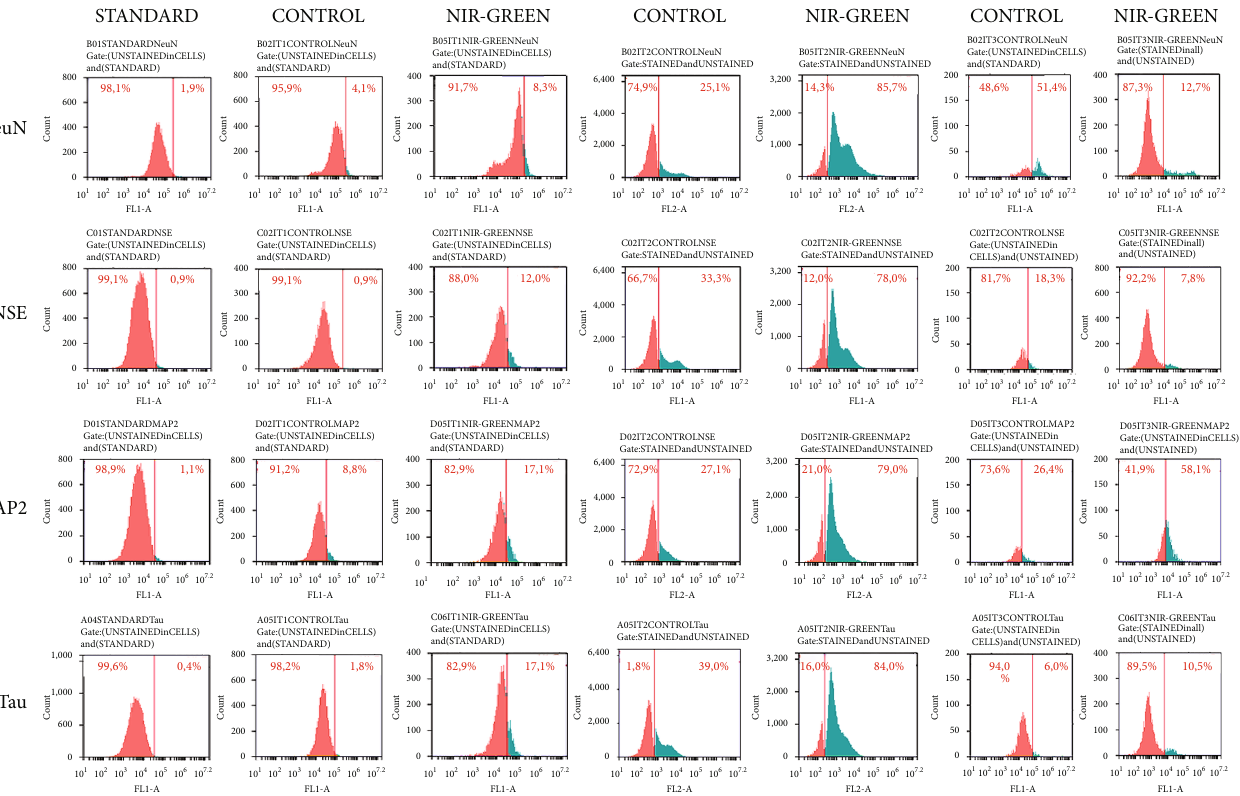
Figure 3: Characterization of transdi ff erentiated iADSCs using neuronal markers NeuN, NSE, MAP2, and Tau. Fluorescent protein detection through fl ow cytometry. Flow cytometry analysis revealed an increase in neuronal markers 7 days postlaser treatment. A shift to the right in distribution indicated an increase in neuronal marker